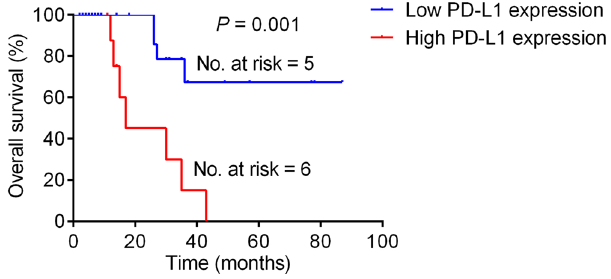
Figure 4. Kaplan–Meier analysis of overall survival in the patient cohort stratified by PD-L1 status.